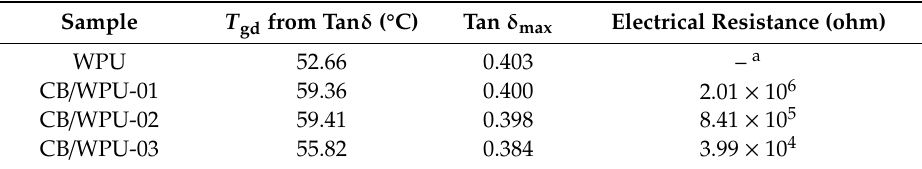
Table 3. DMA and electrical resistance results of the CB / WPUs.